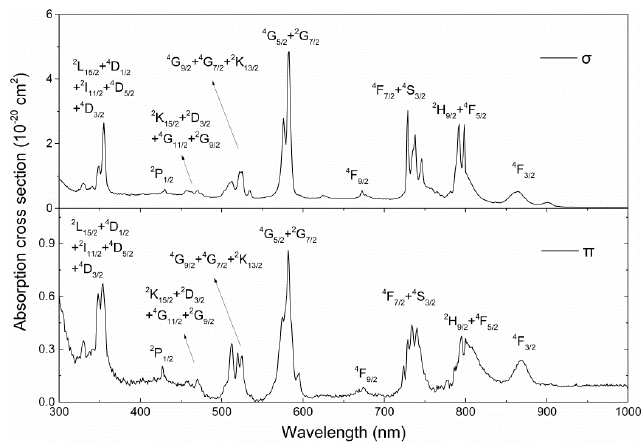
Figure 1. Polarized absorption cross-section spectra of a Nd:Sr 0.7 La 0.3 Mg 0.3 Al 11.7 O 19 (Nd:ASL) crystal at room temperature.